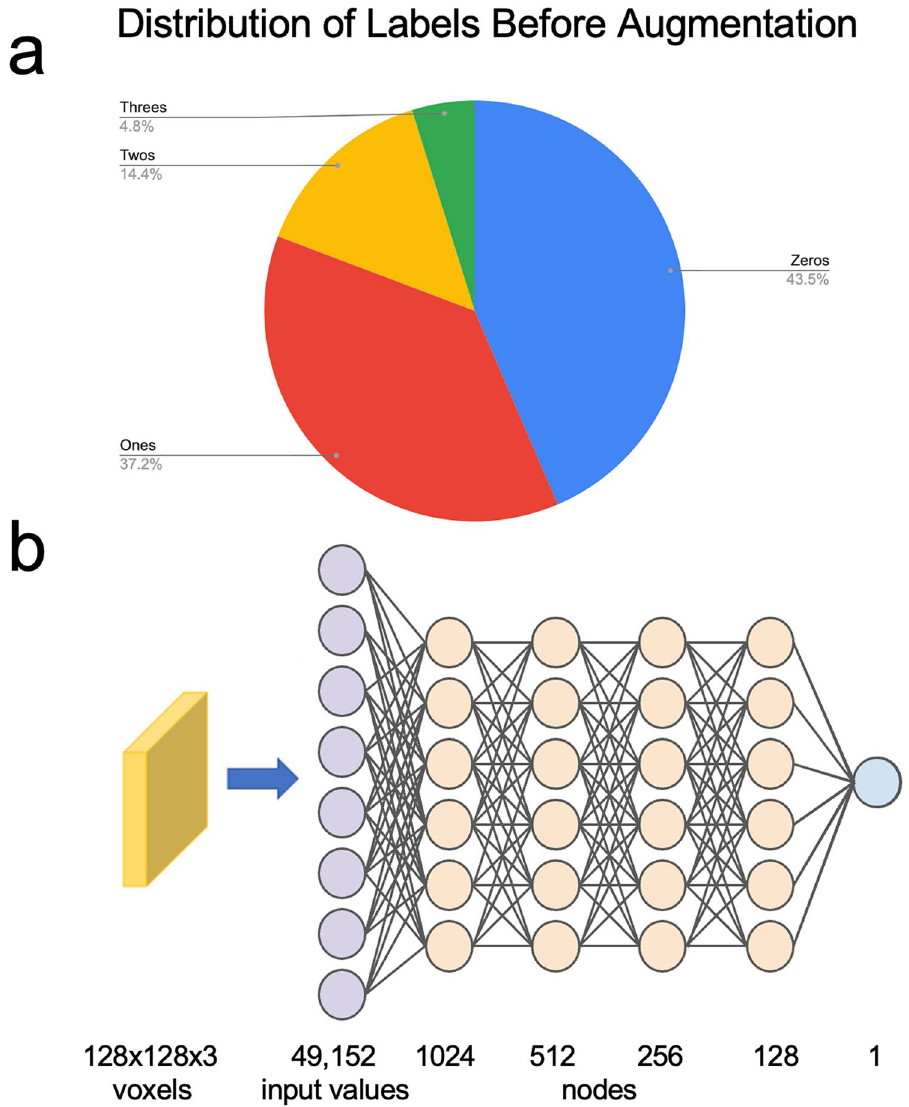
Figure 3. ( a ) Initial distribution of MOAKS-ES labels before data augmentation. ( b ) Schematic of network architecture. A flattened 49,152-valued input layer is followed by dense layers with 1,024, 512, 256, and 128 nodes, with 10% dropout after the first dense